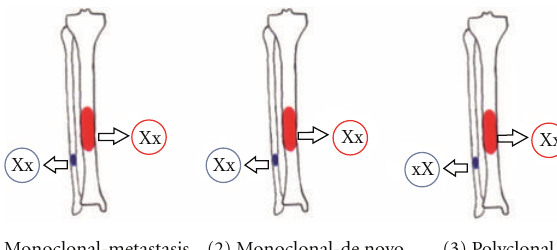
Figure 9: Schematic illustration of possible clonal origin of two lesions in case of multifocal/multicentric adamantinoma. The Xx and xX are representing the random X inactivation pattern in the respective